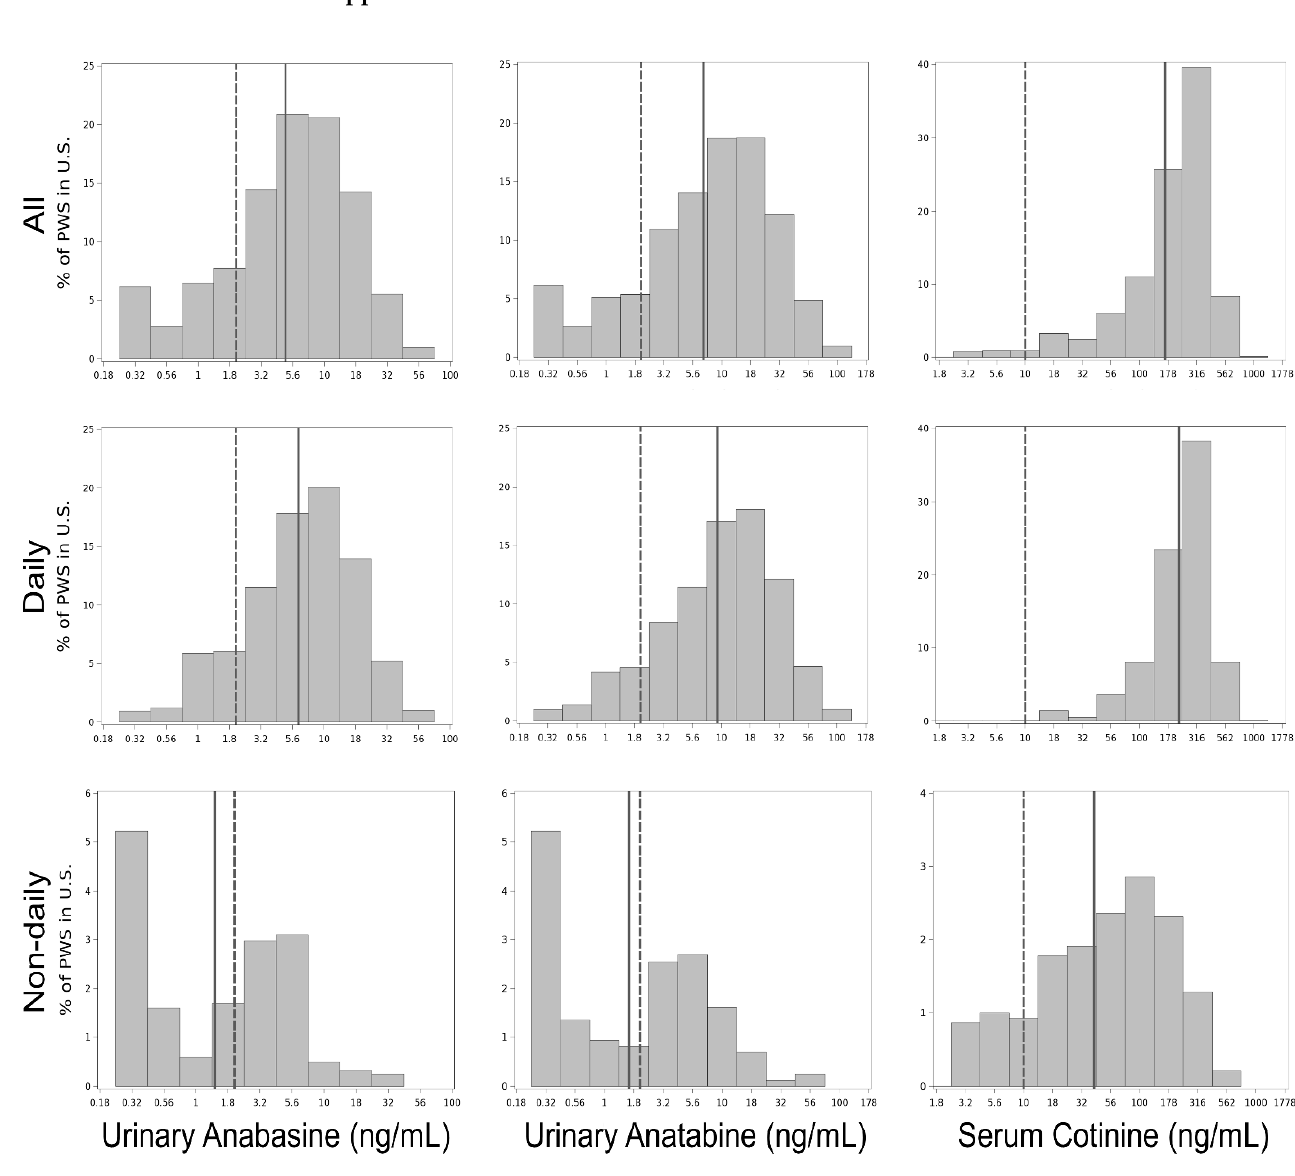
Figure A2. Weighted histograms of log 10 -transformed urinary anabasine, urinary anatabine, and serum cotinine levels of all people who smoke ( n = 770) and those who smoke daily ( n = 721) and non-daily ( n = 49). Frequency is presented as a percentage of people who smoke in the U.S. The presented log-transformed concentrations were exponentiated to simplify interpretation. Geometric means and cut points of each biomarker are indicated by solid and dashed gray lines, respectively.